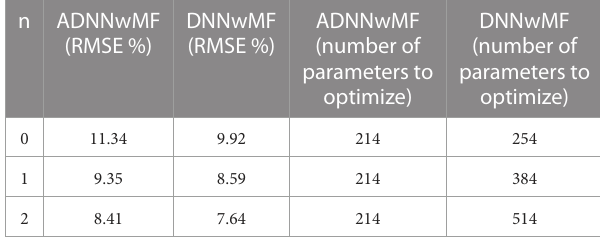
TABLE2 RMSE(%)for n = 0 , 1 , 2 forADNNwMFandDNNwMFand correspondingnumberofoptimizationparameters.